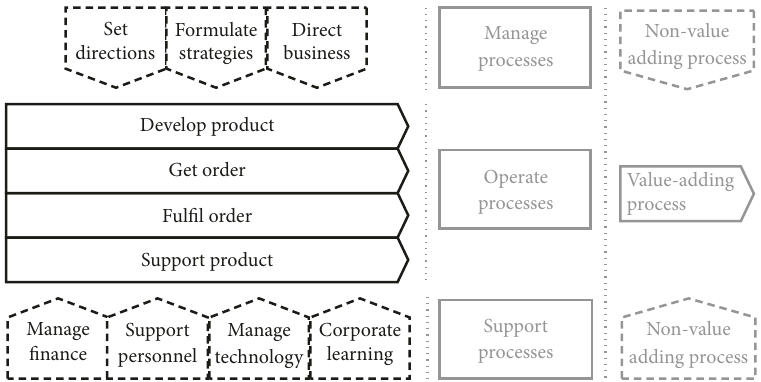
Figure 4: Business process architecture, redrawn from Bititci et al. [24,